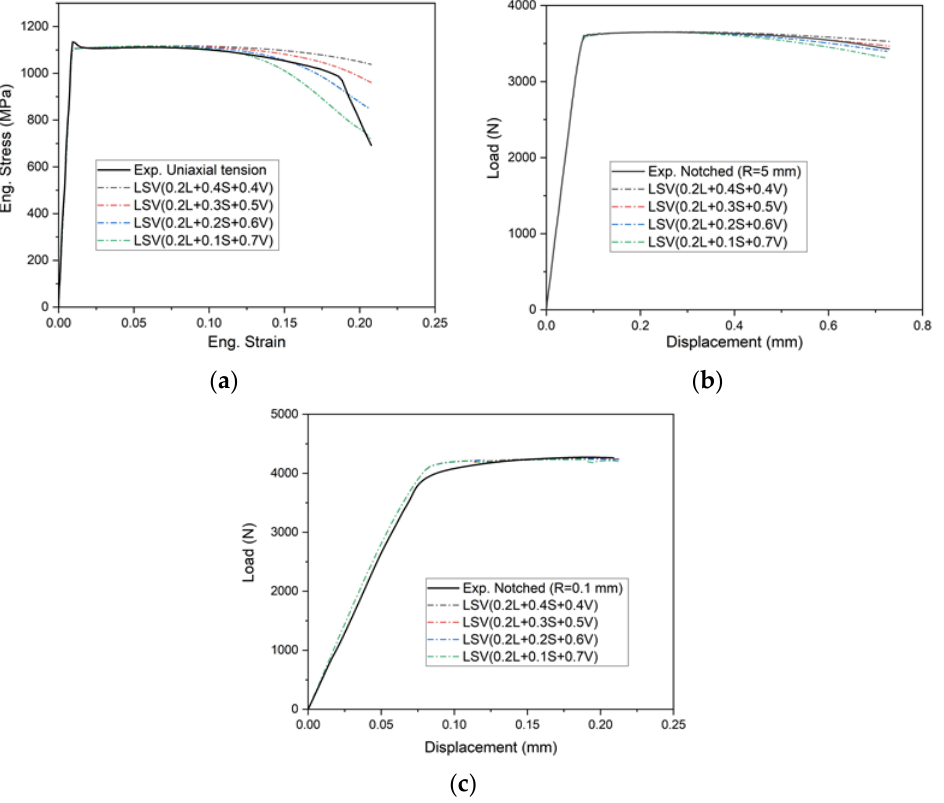
Figure 11. Comparison of loading curves from numerical and experimental results for: ( a ) uniaxial tension; ( b , c ) notched tension (R = 5, 0.1 mm) samples. tension; ( b , c ) notched tension (R = 5, 0.1 mm)